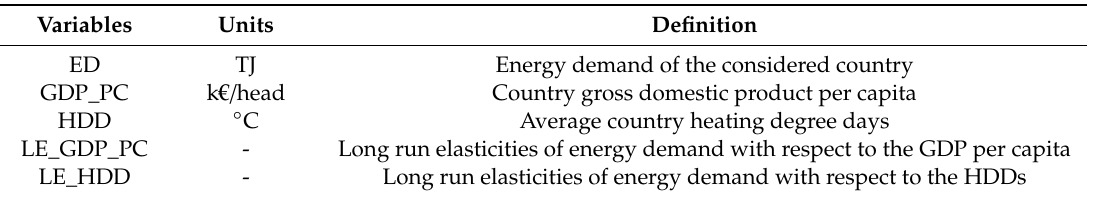
Table 1. Variables considered in the proposed forecasting